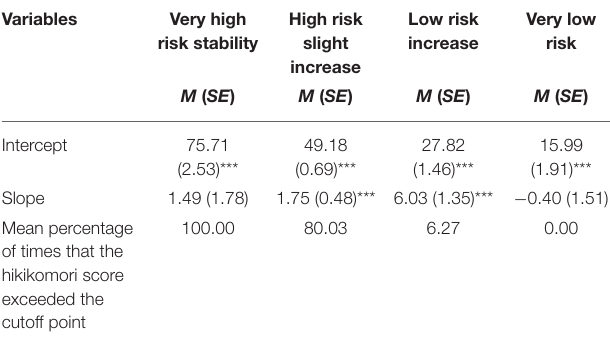
TABLE 5 | Growth parameters for the final four-class